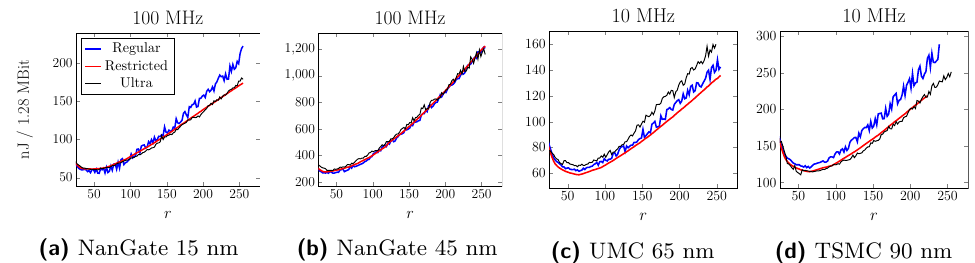
Figure 15: Grain-128 energy measurements for three synthesis settings and cell libraries. The complete set of plots for different frequencies is given in Appendix F, Figure 19. Table 2: Subterranean-Deck energy measurements for r = 4 for four cell libraries. nJ/1.28 MBit Regular Ultra